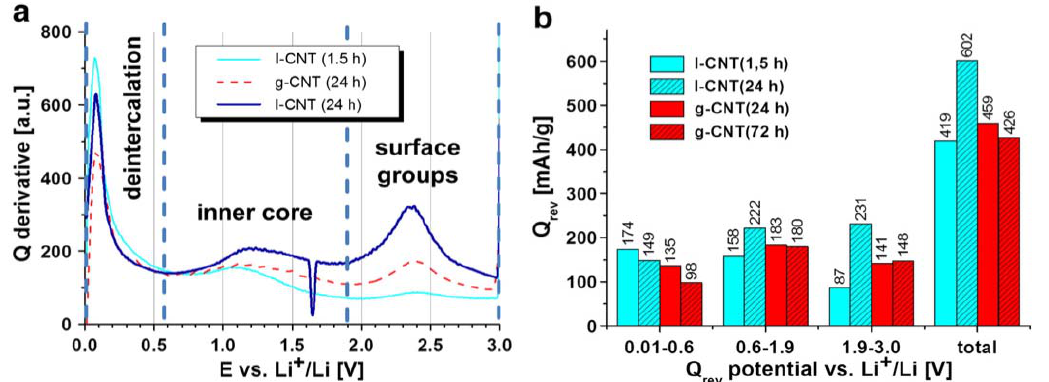
Figure 2. ( a ) Derivative of 1st cycle reversible capacity; and ( b ) reversible capacity of g-CNT (carbon nanotube) and l-CNT, divided into three potential areas of graphene layer deintercalation (0.01–0.6 V), inner core deinsertion (0.6–1.9 V) and extraction